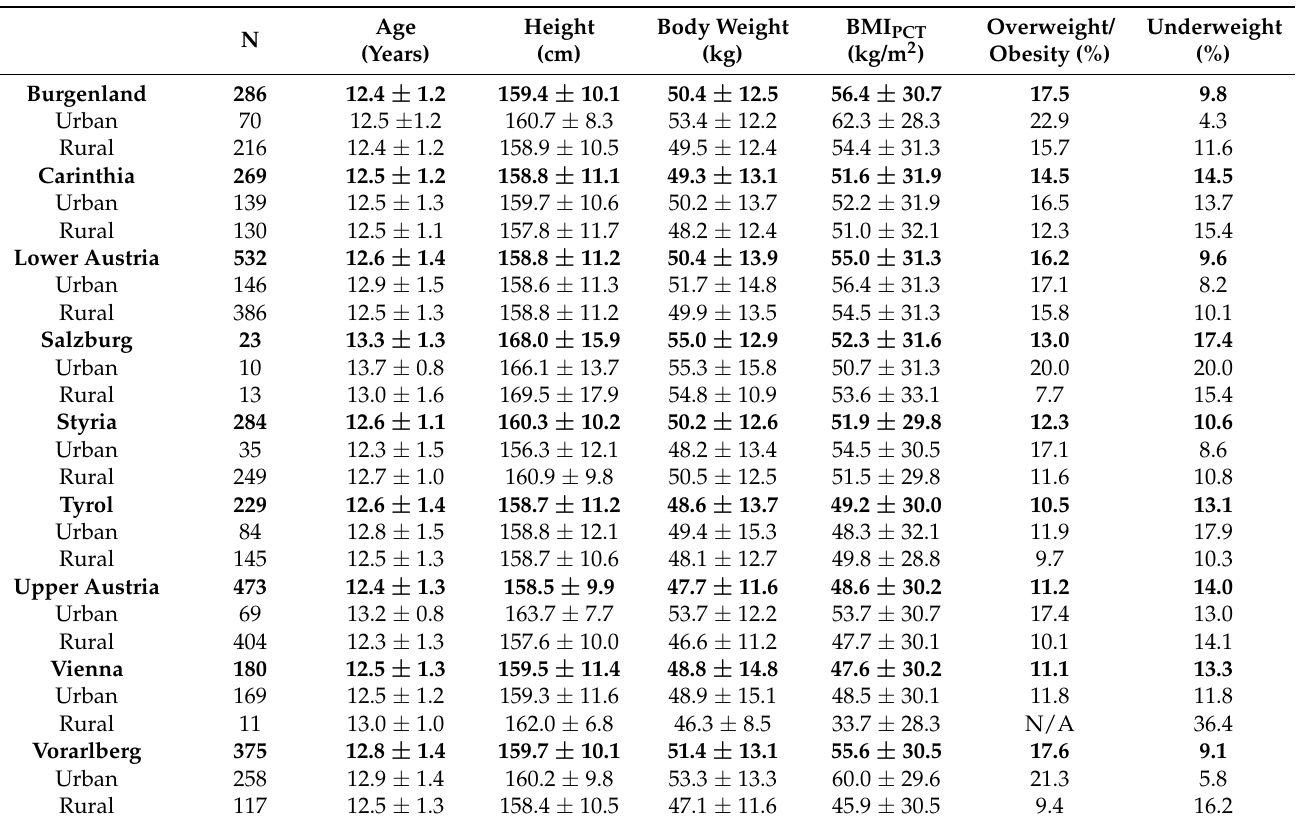
Table A1. Anthropometric Characteristics by federal state and living area in secondary level I pupils. Values are means ± SD and prevalence for weight